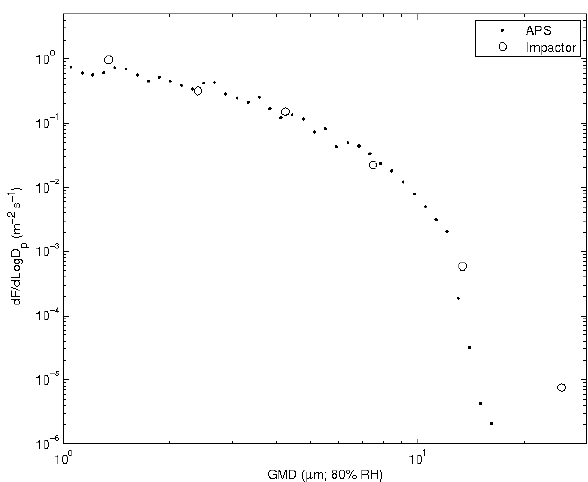
Fig. 1. Number production fluxes of artificially generated aerosols measured with an APS (solid diamonds) and the corresponding number production fluxes calculated from size-resolved aerosol mass sampled with a cascade impactor and analyzed by ion chro- matography (open